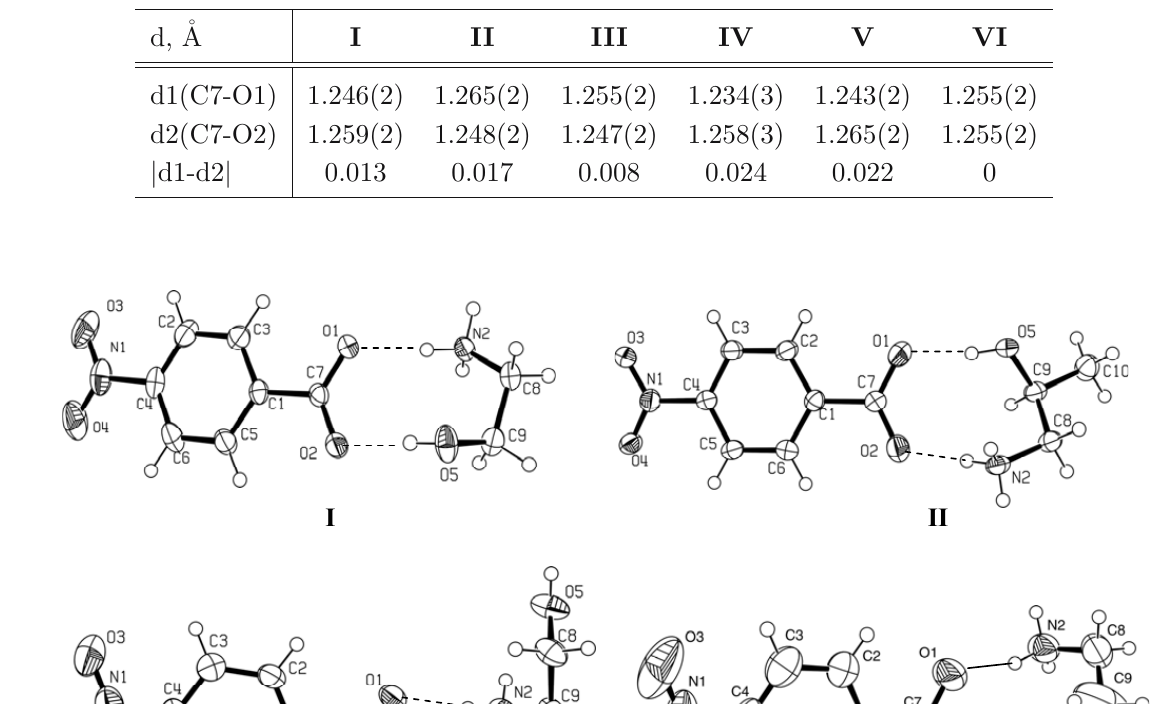
Table 3 The bond lengths (˚ A) in carboxylate groups and absolute values of their differ- ences.